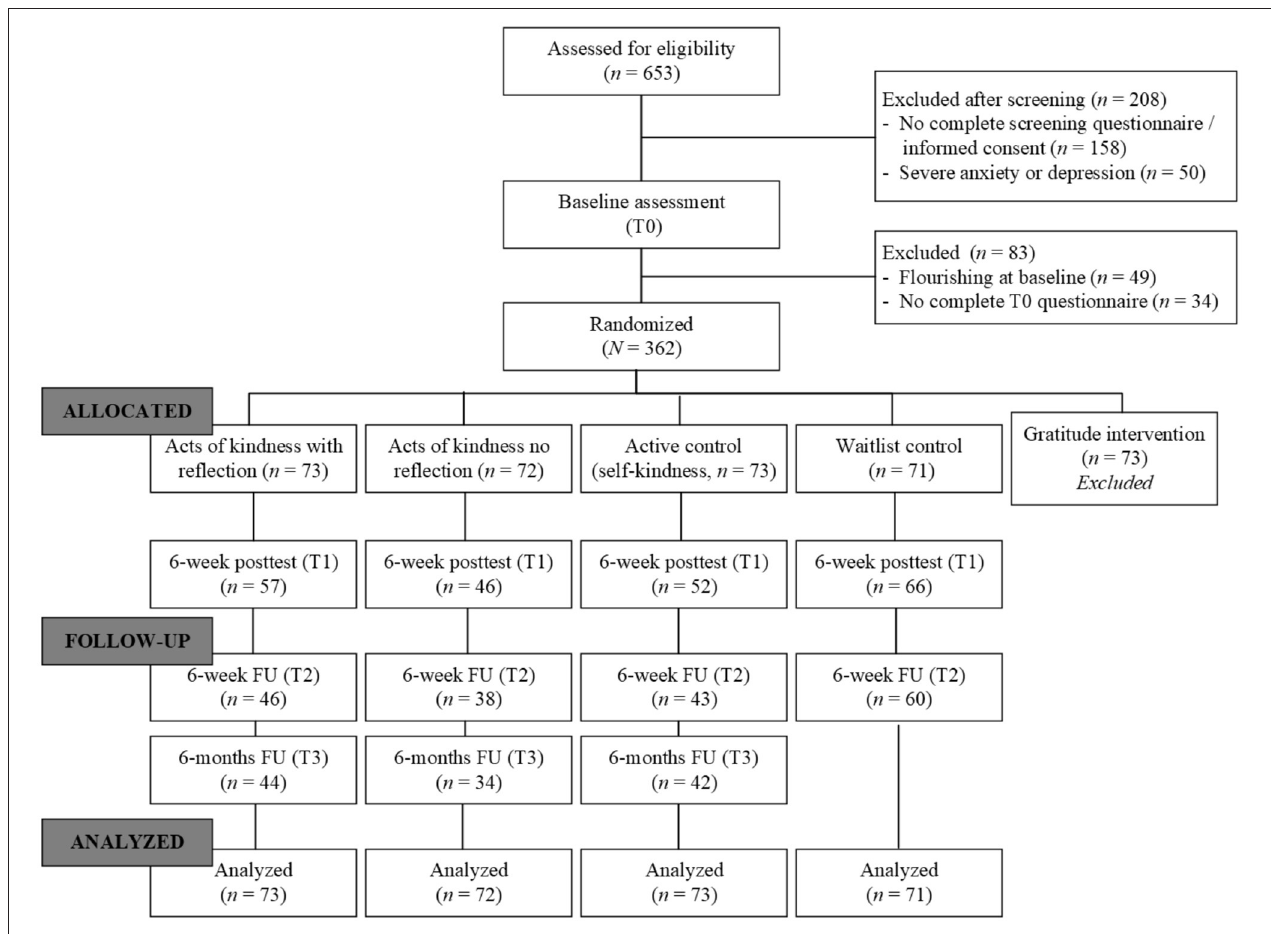
FIGURE 1 | CONSORT flow-chart of